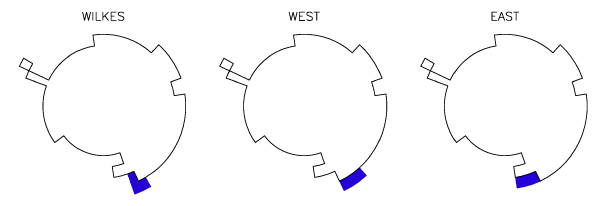
Figure 2. Locations of freshwater input in experiments WILKES, WEST and